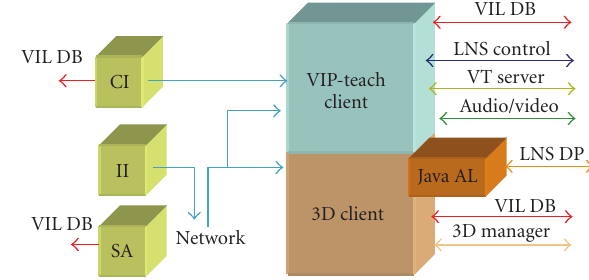
Figure 8: Main components of the remote